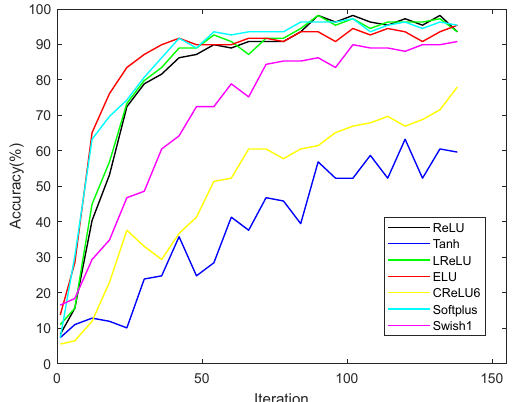
Figure 7. Trends in validation accuracy for transfer learning on ResNet50 with seven different activation functions.